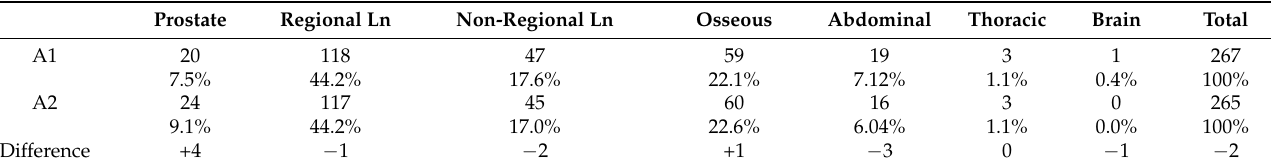
Table 8. 68 Ga-PSMA-PET/CT lesions in PCa